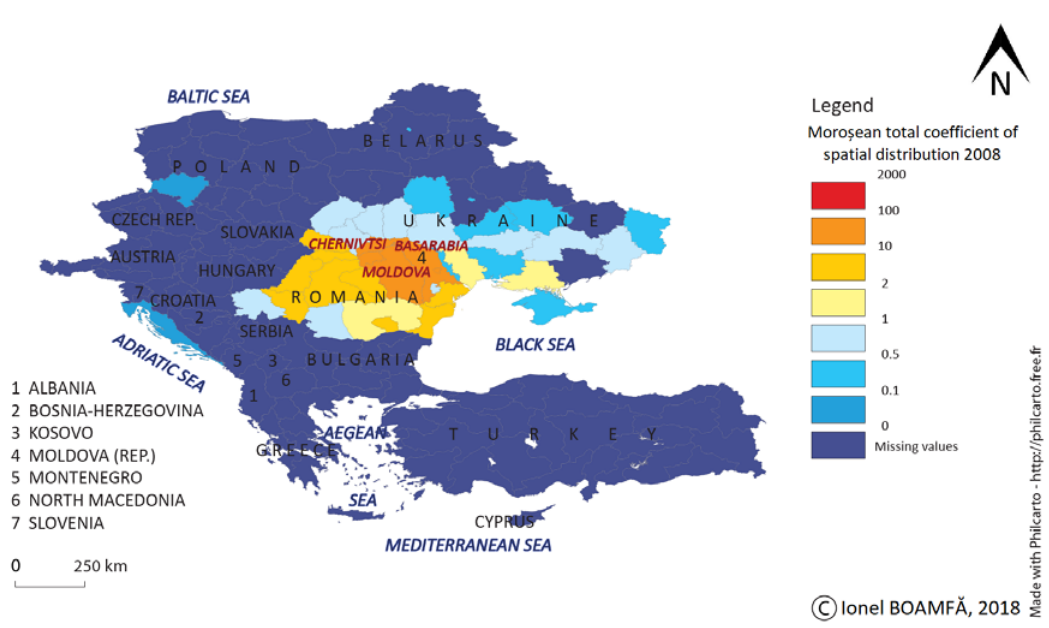
Figur e 14 . G eographical repartition of the anthroponym Moroșean. Coef. of spatial